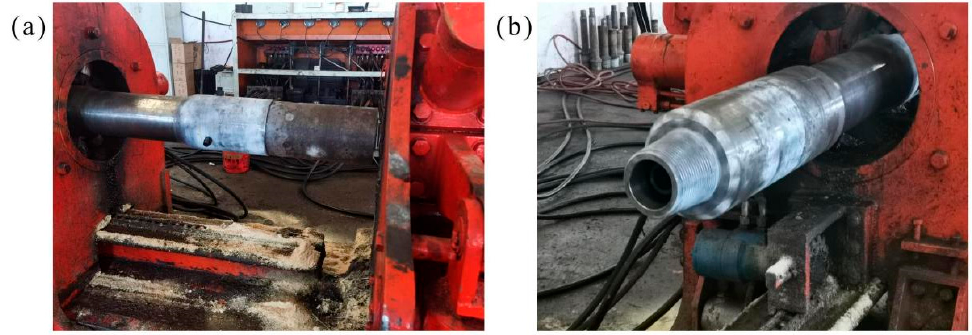
Figure 4. Torsion test equipment. ( a ) Specimen and lower tooling; ( b ) specimen and upper tooling.